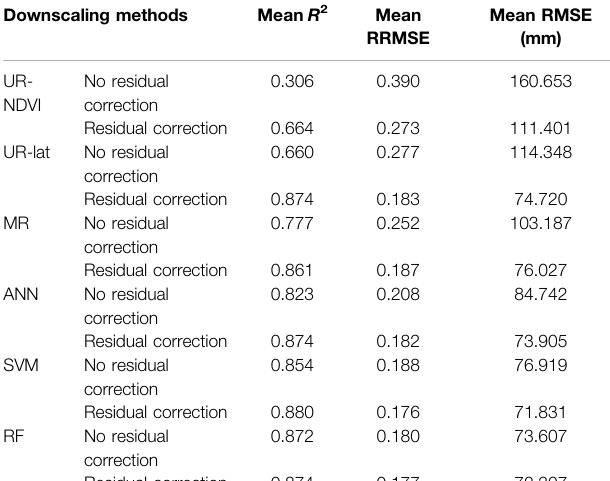
TABLE6| Comparisonoftheevaluationmetricsofdifferentdownscalingmethods at monthly scale from 2001 to 2015 with and without residual correction. Downscaling